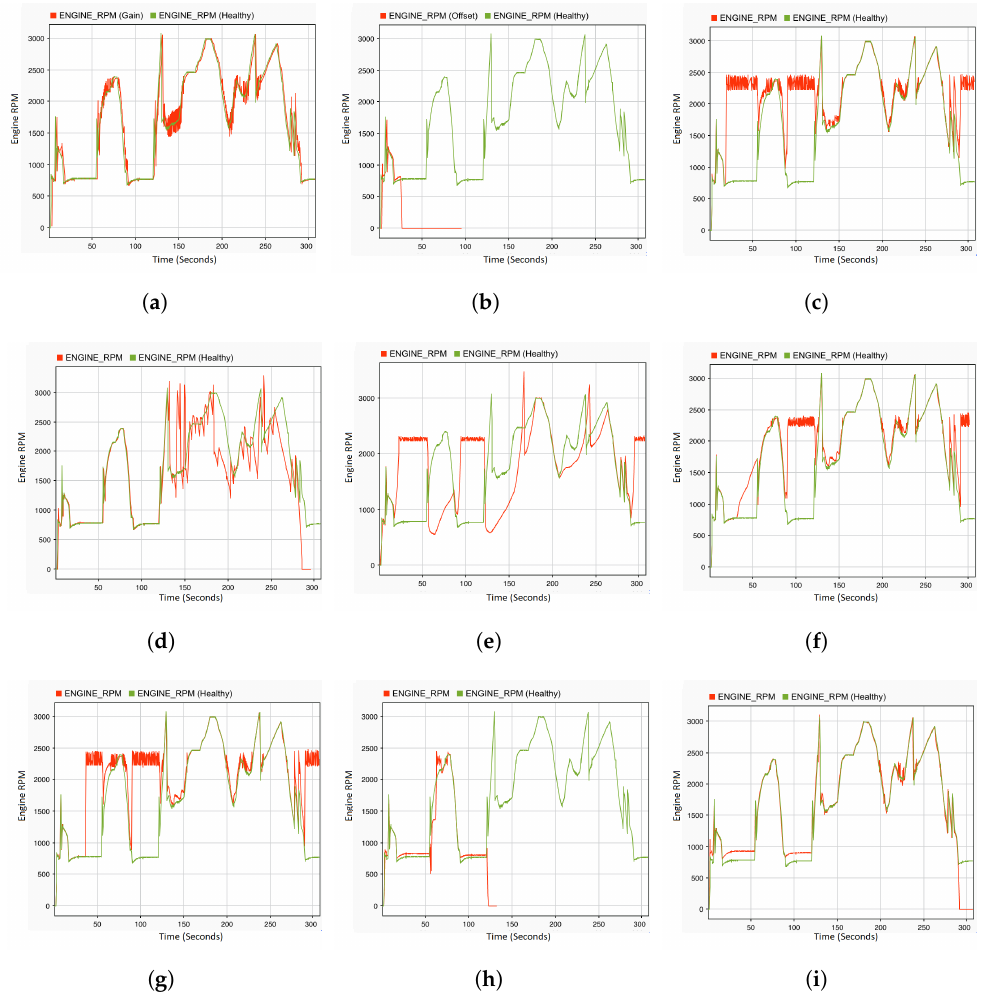
Figure 10. System output: engine RPM with single permanent fault injection. ( a ) Acceleration pedal with gain fault. ( b ) Engine RPM sensor with offset fault. ( c ) Acceleration pedal with noise fault. ( d ) Rail bar sensor with packet loss fault. ( e ) Engine RPM sensor with stuck-at fault. ( f ) Acceleration pedal with drift fault. ( g ) Acceleration pedal with hard-over fault. ( h ) Mass flow through throttle with spike fault. ( i ) Engine RPM sensor with delay